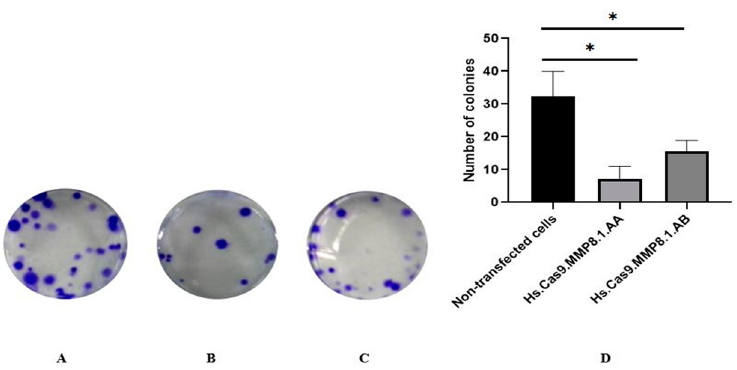
Figure 1. Colony formation decrease of A549 cells on treatment with Hs.Cas9.MMP8.1.AA and Hs.Cas9.MMP8.1.AB gRNAs for 14 d. ( A ) Non-transfected cells, ( B ) Hs.Cas9.MMP8.1.AA, ( C ) Hs.Cas9.MMP8.1.AB. ( D ) Number of colonies. The experiment was performed in two treatment groups and was compared with the non-transfected cells (* p < 0.05).